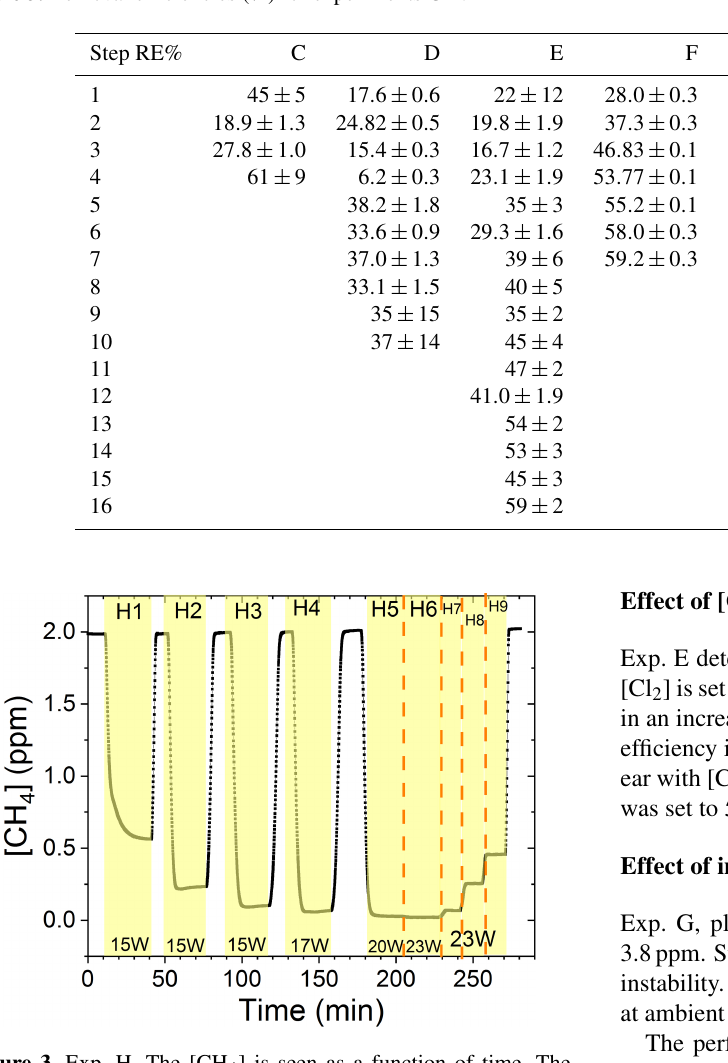
Figure 3. Exp. H. The [ CH 4 ] is seen as a function of time. The highlighting indicates the illumination times. In addition, the exper- imental step is indicated at the top and P IN (W) is indicated at the